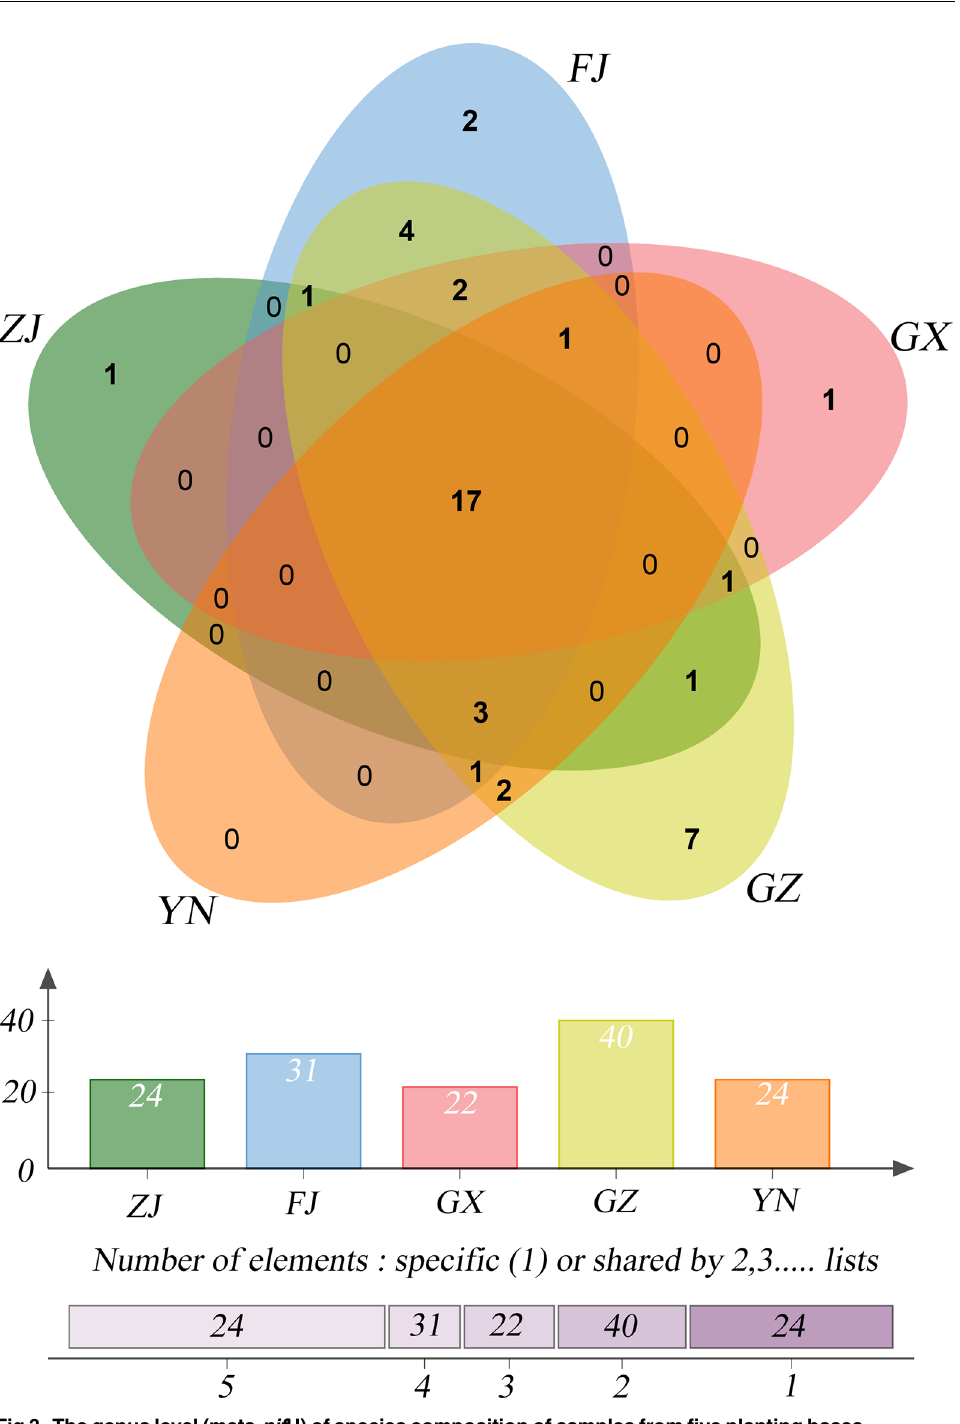
Fig 3. The genus level (meta- nif H)of species composition of samples from five planting bases. were: Proteobacteria (95.18%), Actinobacteria (4.68%), and Firmicutes (0.09%). The stem sam- ples had the same phyla with different ratios, with much less Proteobacteria (69.46%) and more Actinobacteria (13.72%). However, Proteobacteria absolutely dominated in the leaves (99.39%), with few Actinobacteria (0.04%).